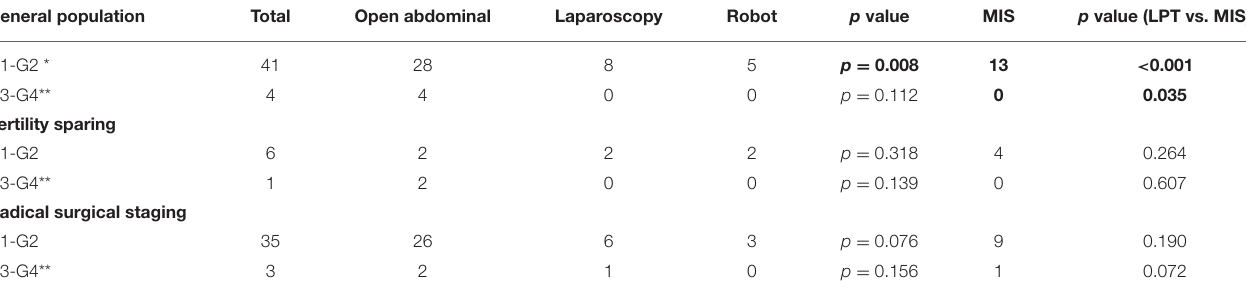
TABLE 3 | Complications according to Claiven-Dindo classification in the different kinds of